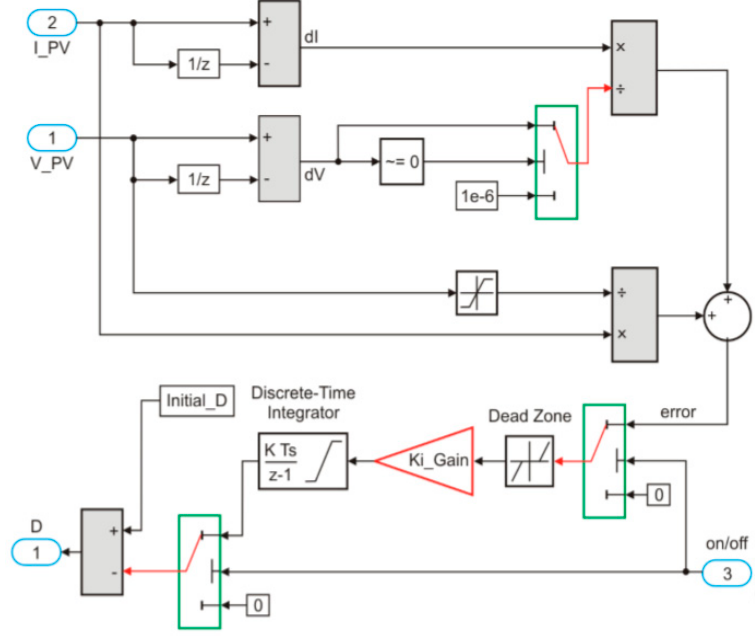
Figure 9. Matlab Model of Integral regulator method.